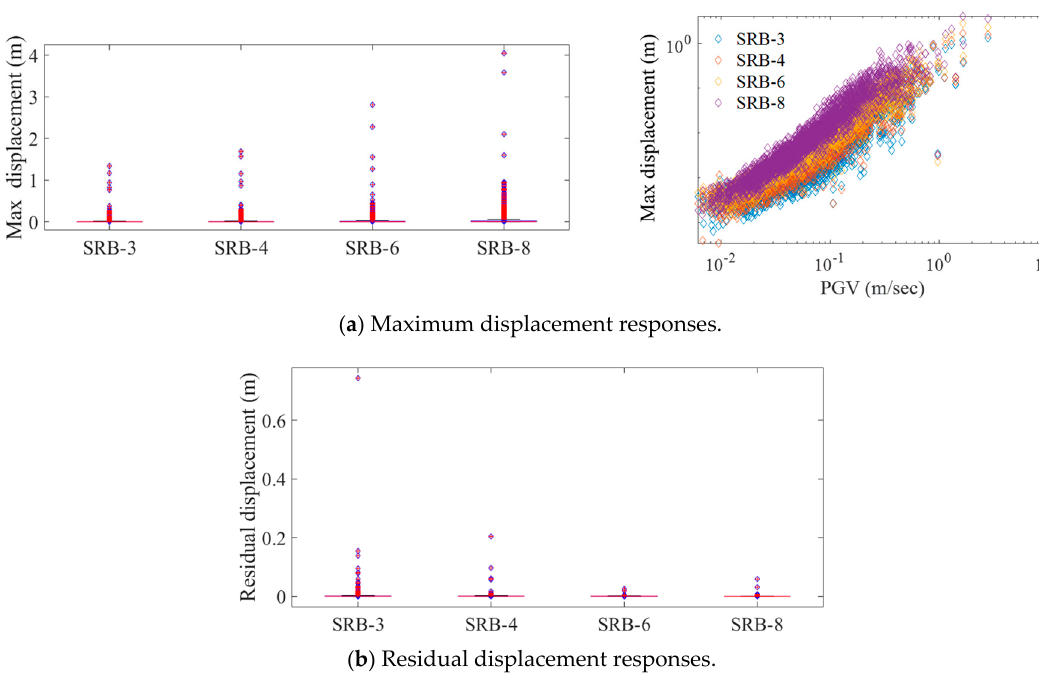
Figure 5. Comparisons of displacement control performances of different SRB models subjected to ground motions of Group 1.